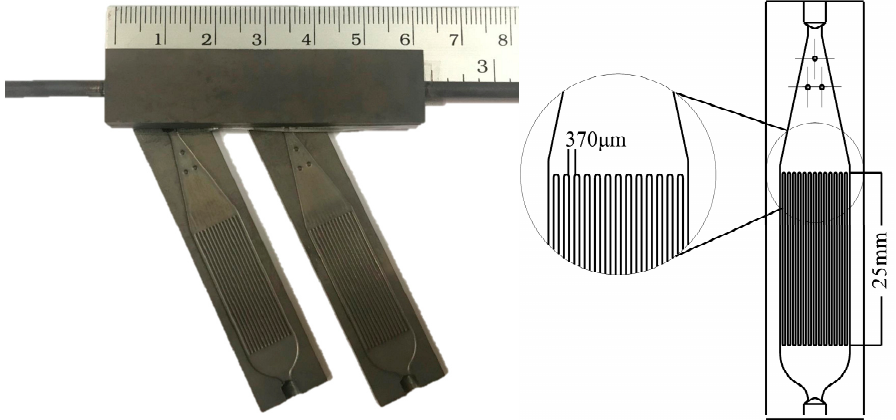
Figure 1. Stainless steel 316L micro - channeled plate.